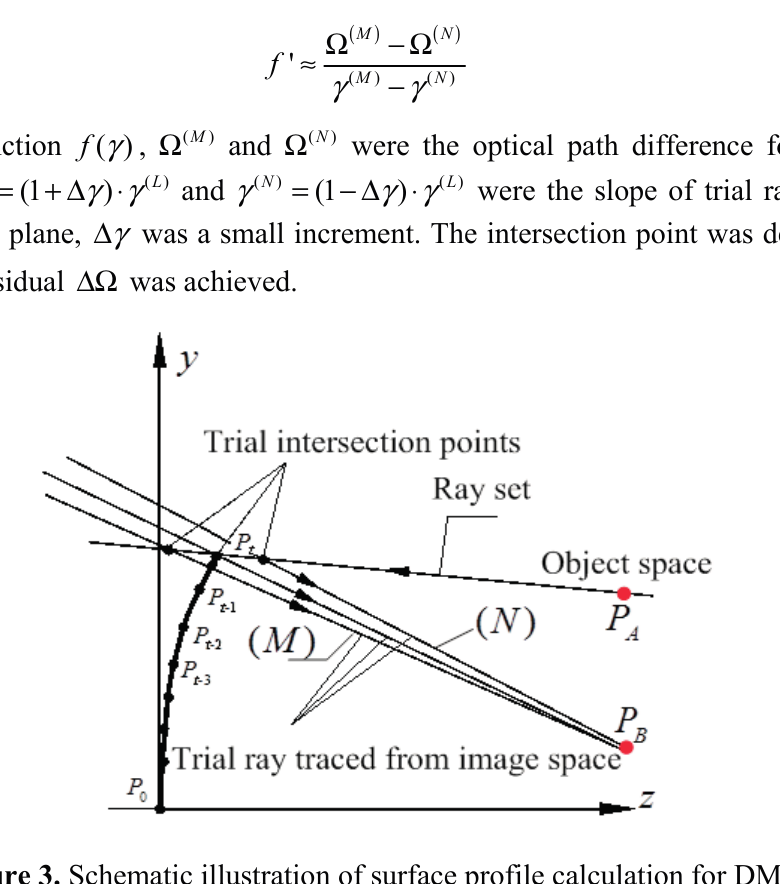
Figure 3. Schematic illustration of surface profile calculation for